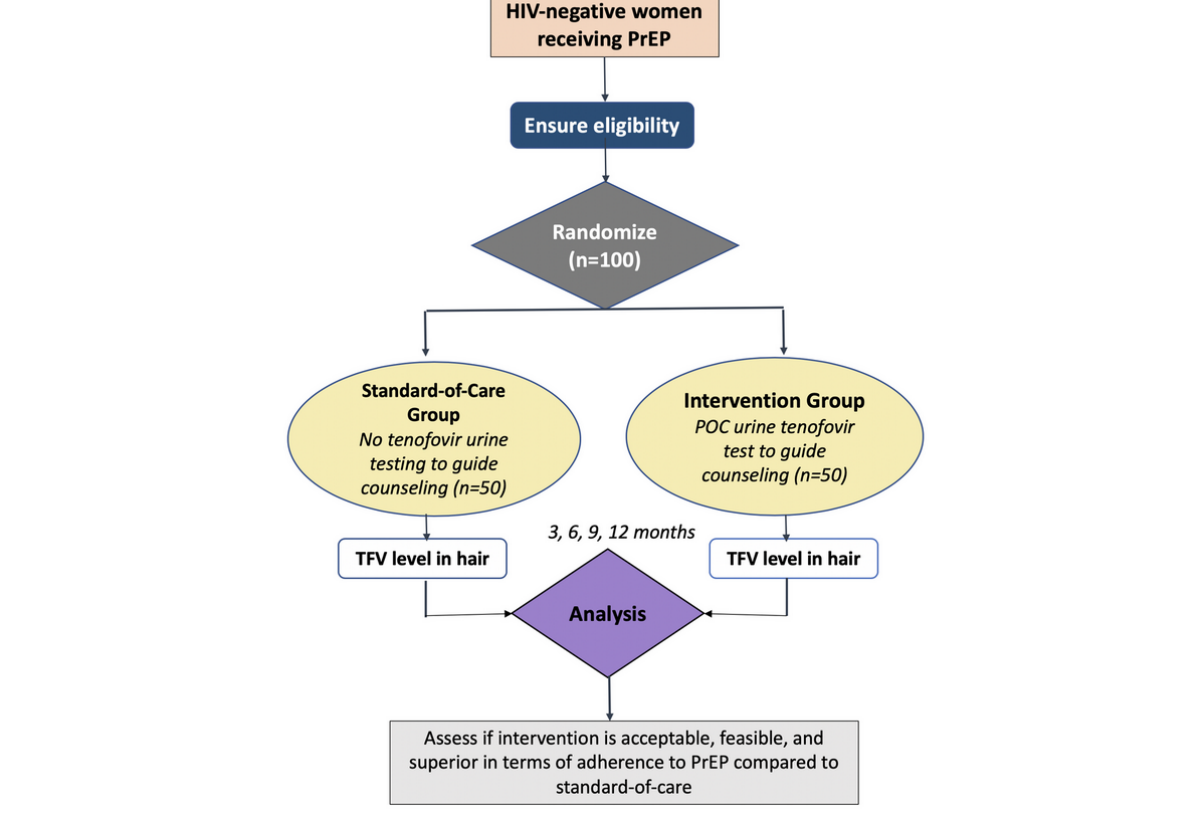
Figure 2. Schema for the PUMA study. PUMA: Point-of-Care Urine Monitoring of Adherence; PrEP: preexposure prophylaxis; TFV: